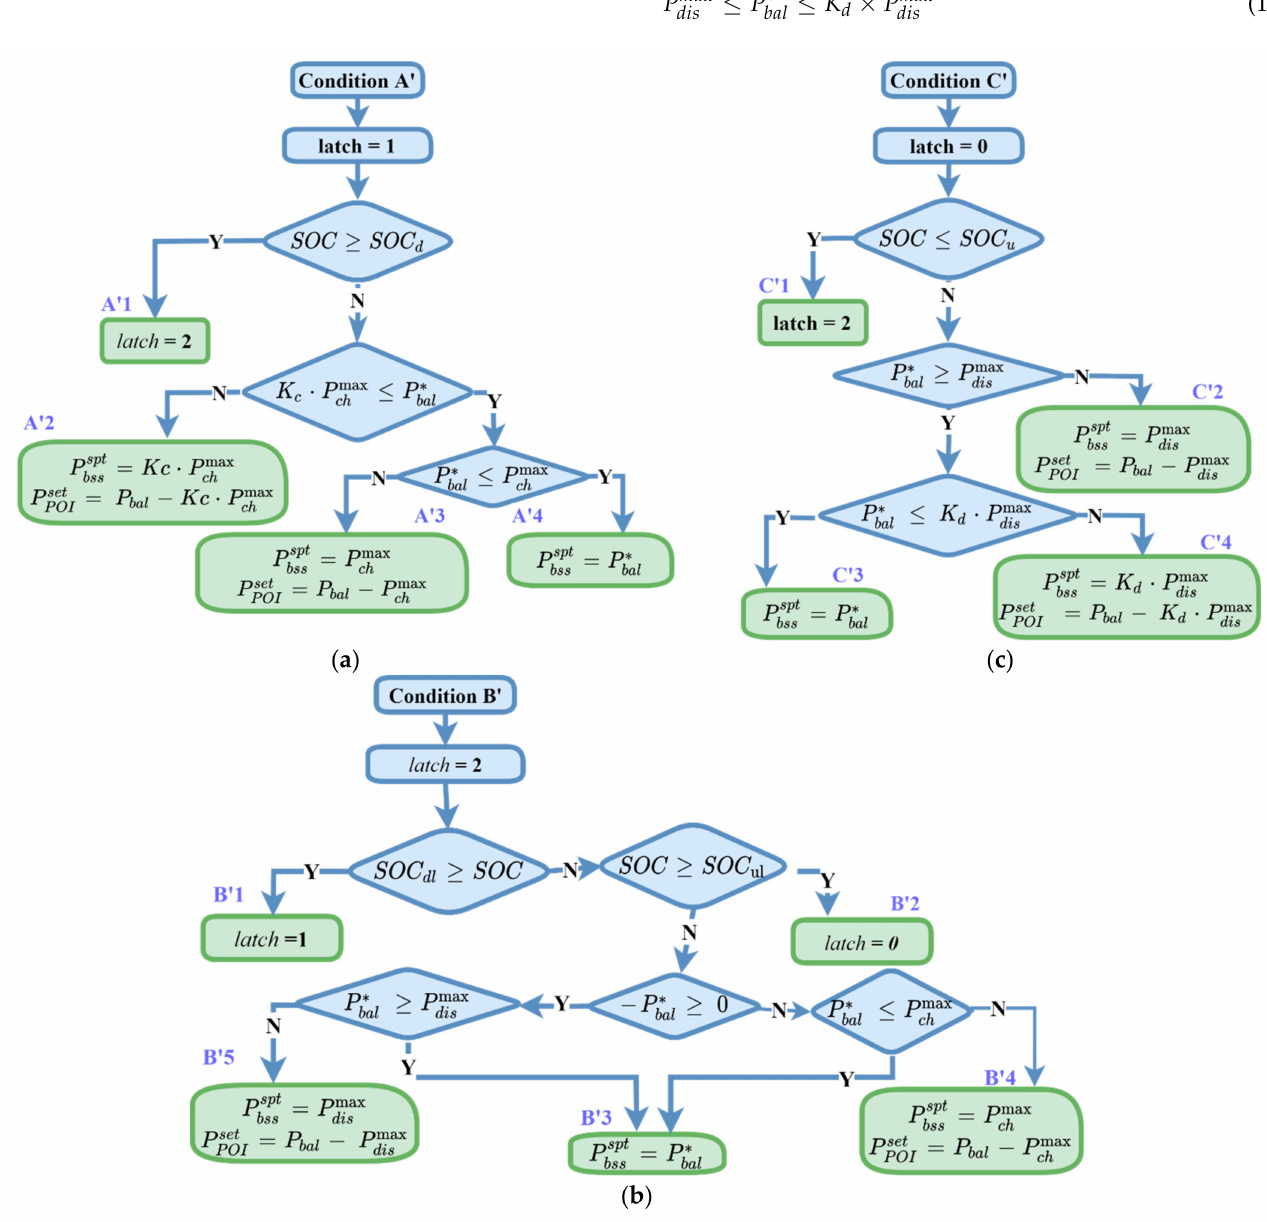
Figure 9. Control rules of dispatch function in SS1 based on the ranges of BSS’ SOC: ( a ) BSS force-charging control rule. ( b ) BSS power-smoothing control rule. ( c ) BSS force-discharge control